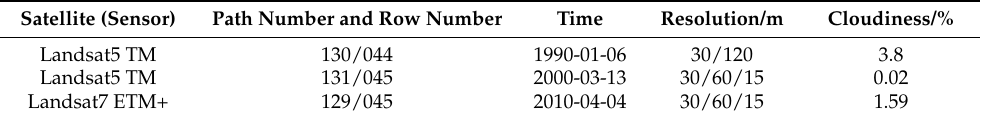
Table 1. Landsat imagery used in this study. Satellite (Sensor) Path Number and Row